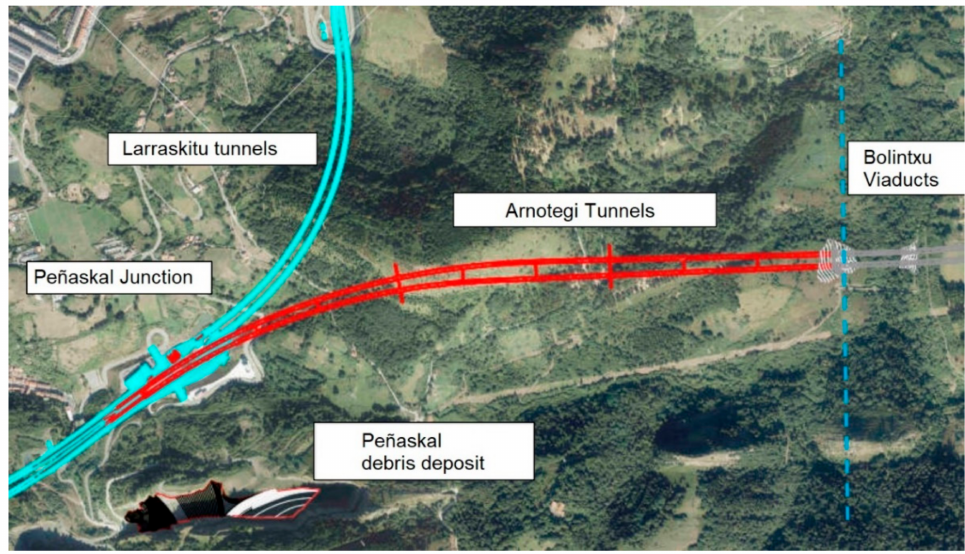
Figure 1. Location plan of the Arnotegi tunnels. View of Larraskitu tunnels (in operation) and Bolintxu viaducts (under